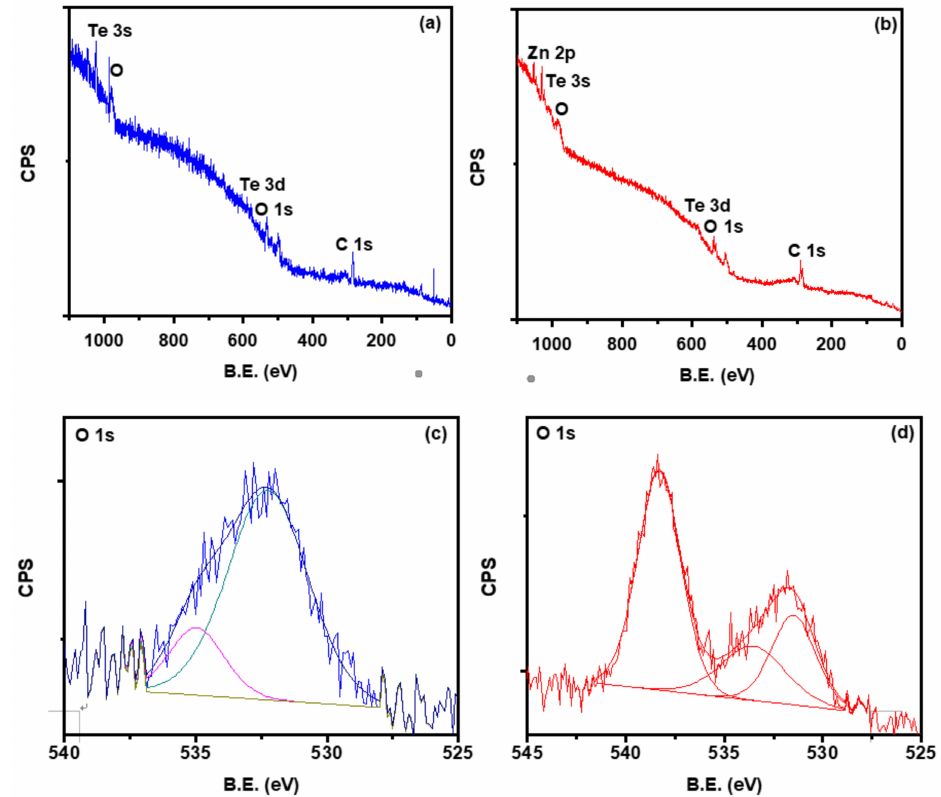
Figure 6. XPS Survey scan of ( a ) un-doped and ( b ) Cu-doped ZnTe thin film samples. De-convoluted XPS analysis of Oxygen-1s for ( c ) un-doped and ( d ) Cu-doped ZnTe thin film samples. The high resolution XPS measurements were performed for Zn-2p spectra, while the de-convoluted fitted peaks for Zn-2p 3 / 2 and Zn-2p 1 / 2 of un-doped and Cu-doped ZnTe thin film samples are shown